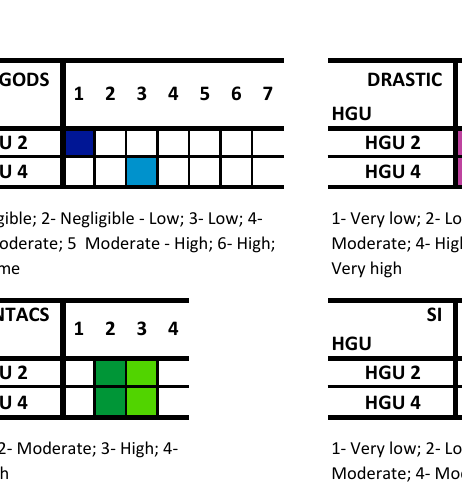
15 of 25 Table 2. Urban groundwater vulnerability assessment in Penafiel urban area (NW Portugal): A statistical overview of GODS, DRASTIC, DRASTIC-fm, SINTACS, and SI results. GODS Index